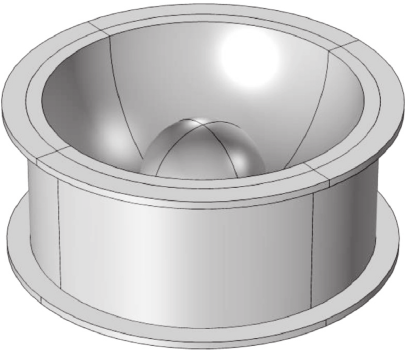
Figure 3: Simulation model of the damper.